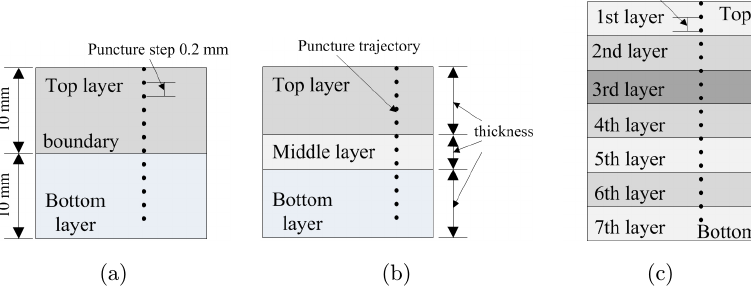
Fig. 5. The schemes of the phantom and experiments. (a) Two-layer model (b) three-layer model (c) multi-layer model.